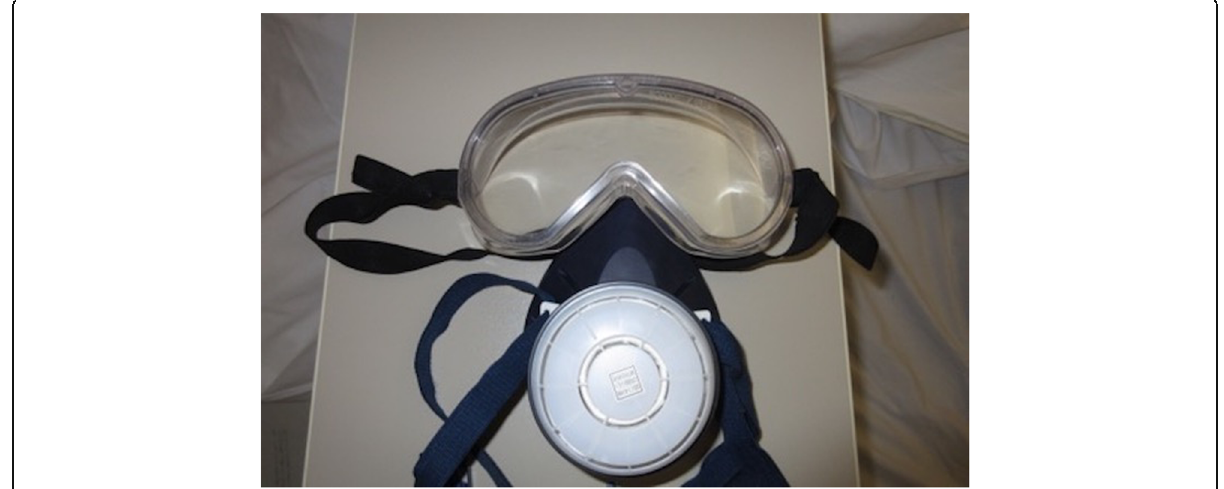
Fig. 1 A sealed gas mask. The patient wears a sealed gas mask and rubber gloves in his daily